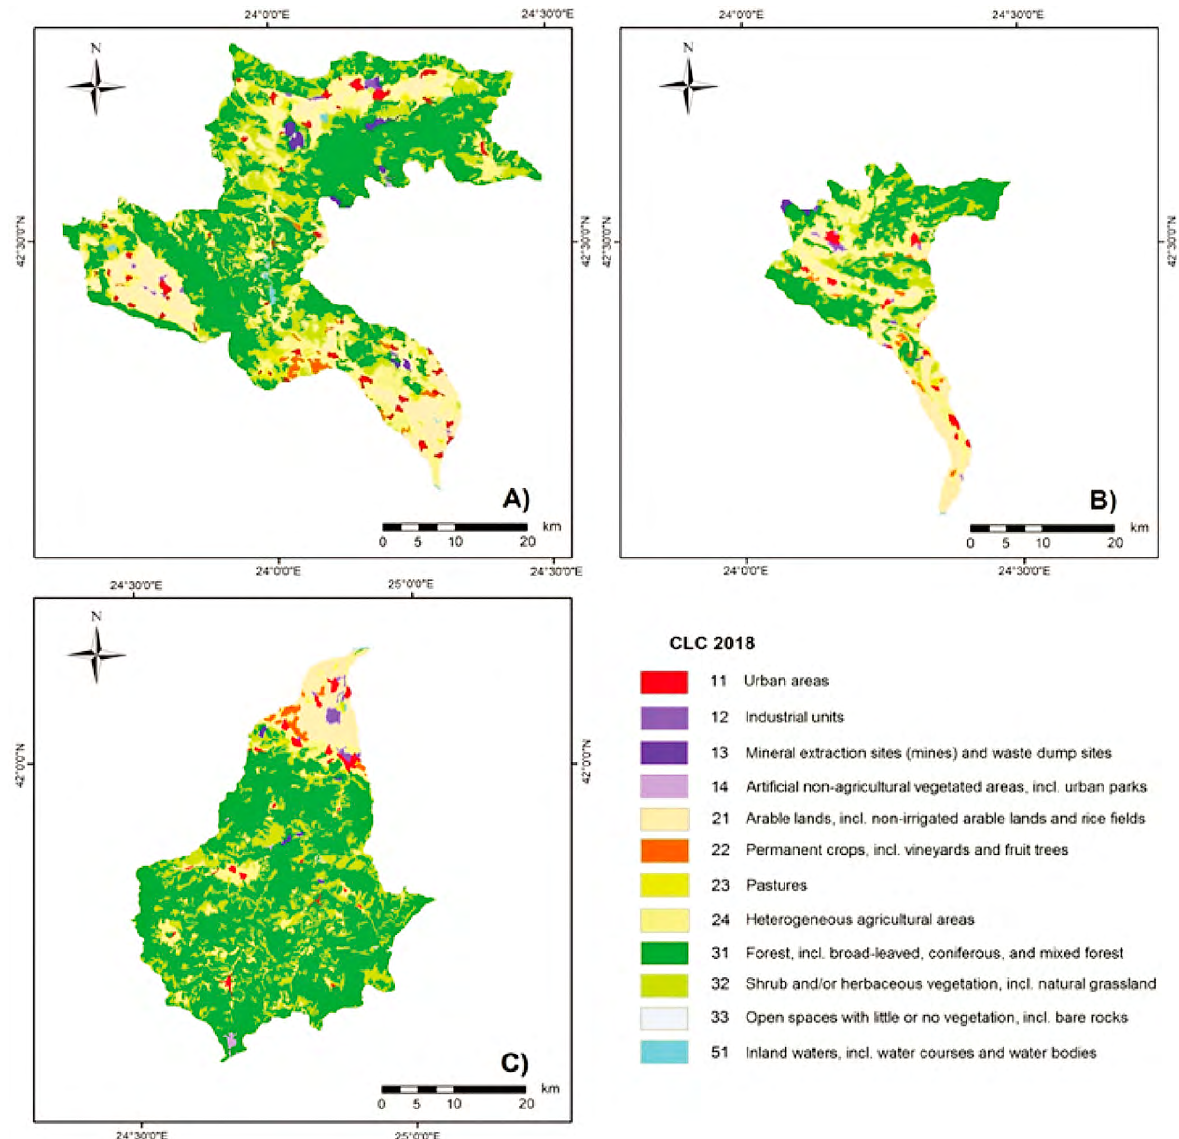
Figure 3. Maps ofCORINE Land Cover (2018): A) Topolnitsa River basin; B) Luda Yana River